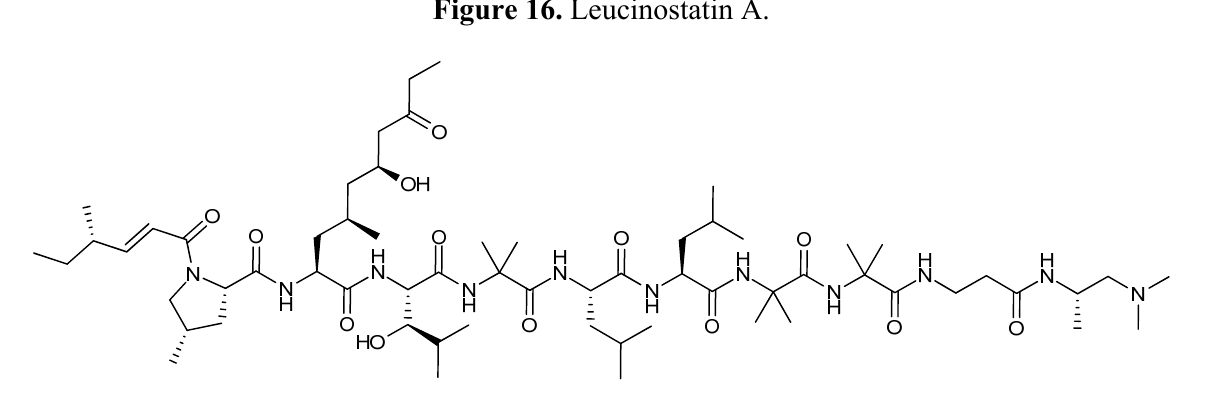
Figure 16. Leucinostatin A.